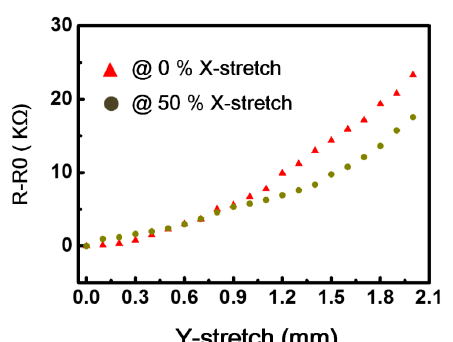
Figure 3. Variation in the resistance of the crumpled graphene strain sensor under different strains in the Y direction for a fixed X-stretch. To monitor the bi-axial strain, the crumpled graphene was stretched in the X direction for predefined values like 50% and 100%, and then, a continuous strain was applied in the Y-direction up to 2 mm at increments of 0.1